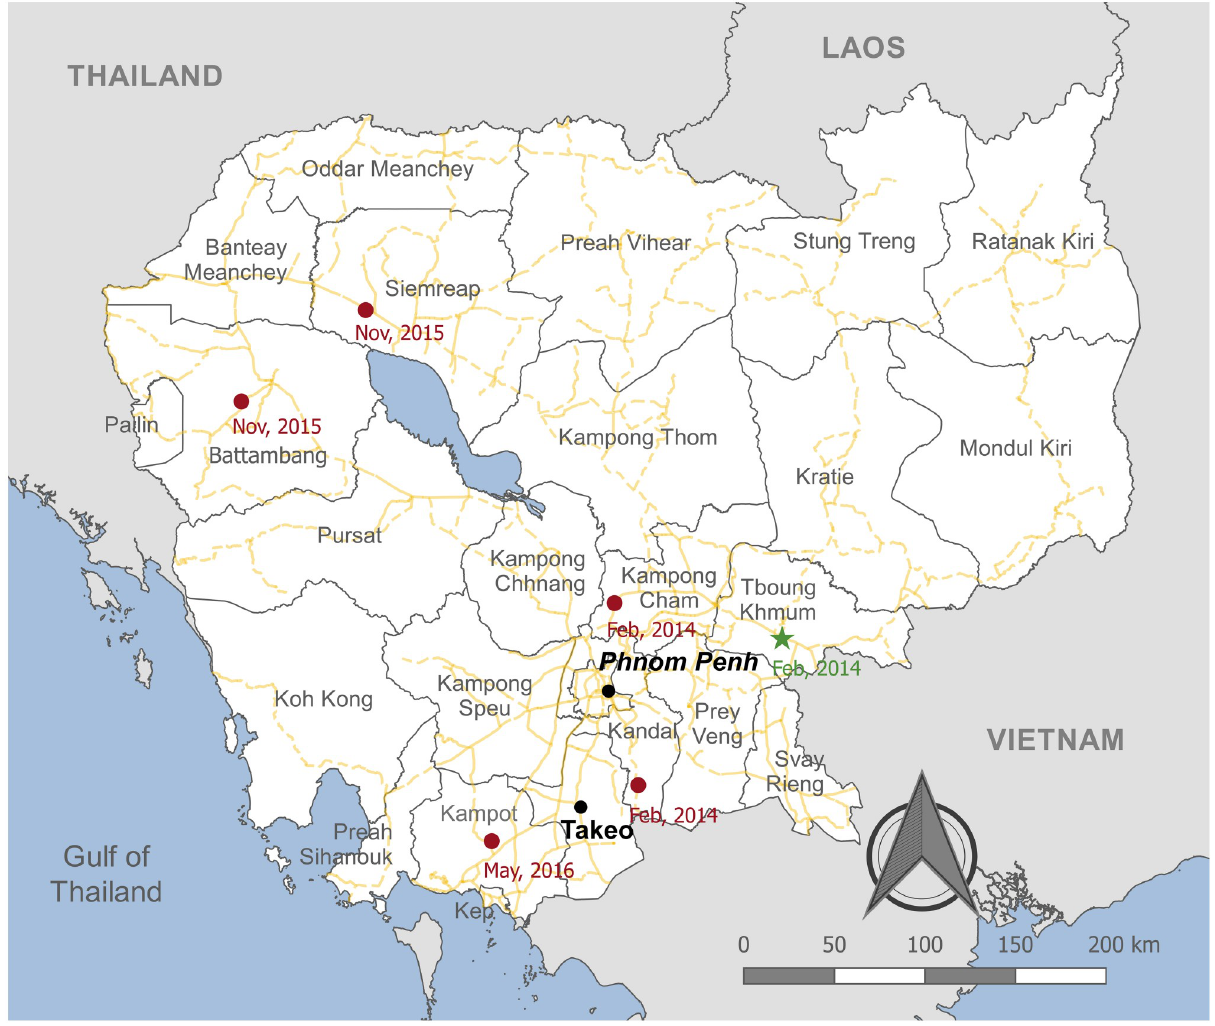
Fig 1. Map of Cambodia showing the locations of live bird market sampling sites, clade 2.3.2.1c AIV human cases and poultry outbreaks from 2014 to 2016. Poultry outbreaks were reported in the provinces: Battambang, Kampong Cham, Kampot, Kandal and Siem Reap. The approximate locations of each outbreak (n = 5) are shown by red circles, with the month and year of the outbreak listed below each site. The LBM surveillance sites were Orussey market in Phnom Penh and Takeo market in Takeo; both markets are indicated by black circles. The location of the single human AIV case caused by a clade 2.3.2.1c virus in Tboung Khmum is indicated by a green star. The map was produced using QGIS version 2.18.4 using public domain data obtained from Natural Earth (http://www.naturalearthdata.com/) [26].